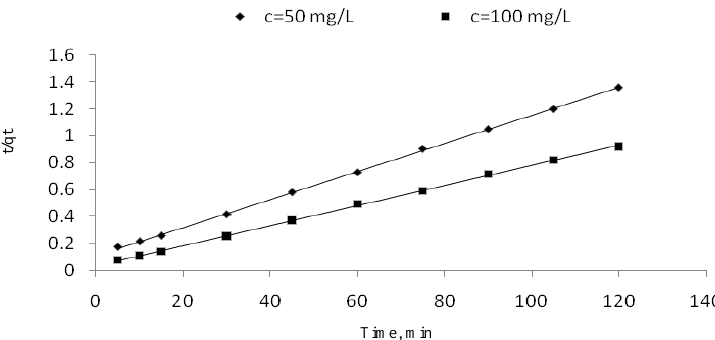
Figure 12. Pseudo-second order kinetic model; Time 120 min, dose: 0.04 g/100 mL, pH